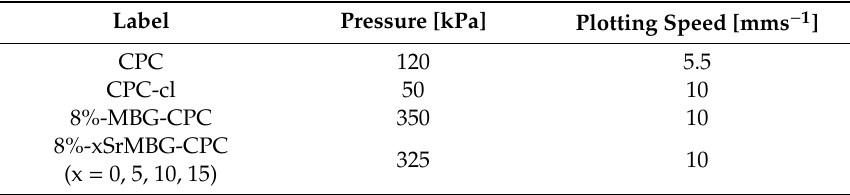
Table 2. Plotting parameters for di ff erent